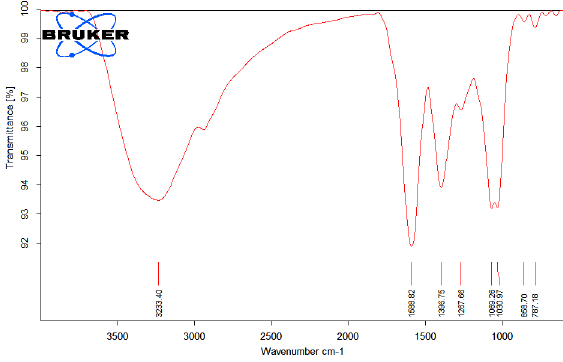
Figure 2. FTIR analysis of Aqueous of Imperata cylindrica